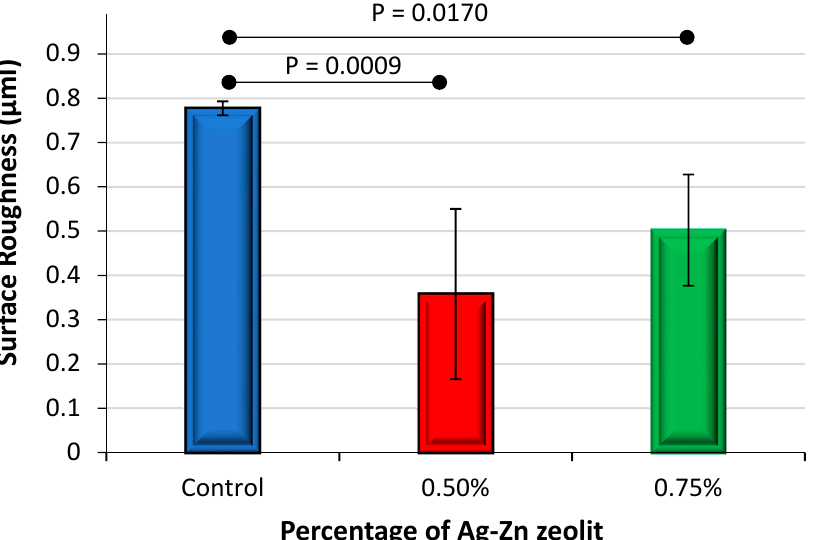
Figure 4. Bar chart showing mean values of the surface roughness in the HC acrylic resin incorporated with Ag-Zn zeolite at different concentrations (0.50 wt.% and 0.75 wt.%) and without any Ag-Zn zeolite (control group). Horizontal lines connecting two bars show statistical significance ( p < 0.05).